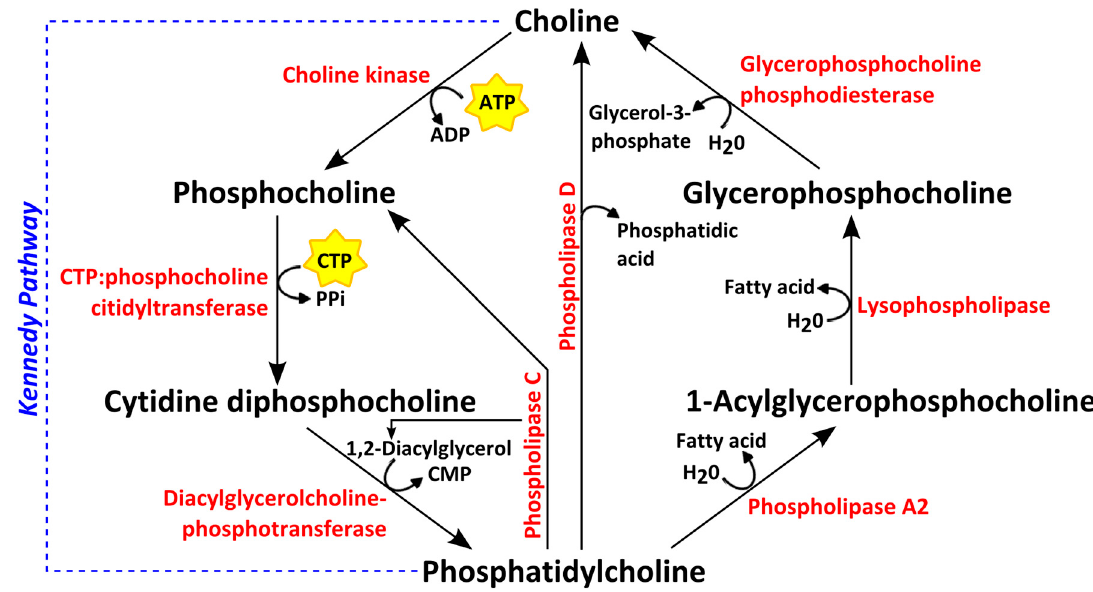
Figure 4. Choline phospholipid metabolism. Enzymes are shown in red. ADP: adenosine diphosphate; ATP: adenosine triphosphate; CMP: cytidine monophosphate; CTP: cytidine triphosphate; PPi: inorganic pyrophosphate.